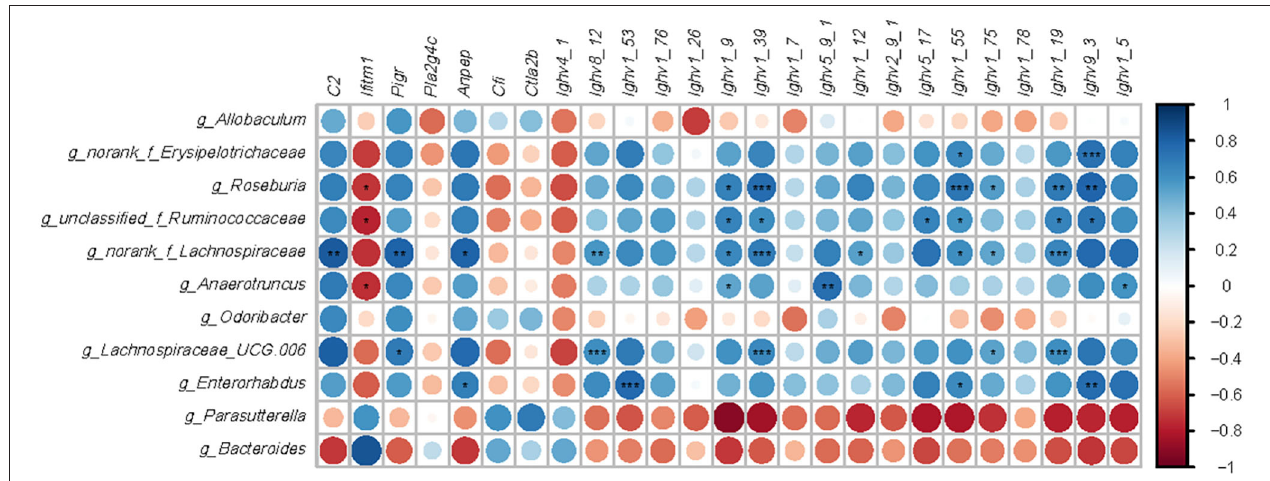
FIGURE 6 | Correlation analysis between microbiota and genes-related immune. Microbes were significantly shifted by a high-fat diet or EGCG treatment. Immune related genes with opposite change trend between two comparisons (HFD vs. Chow and EGCG vs. HFD). Data analysis was based on the Spearman correlation. The blue circle indicated a positive correlation and the red circle indicated a negative correlation. * p < 0.05, ** p < 0.01, *** p < 0.001.